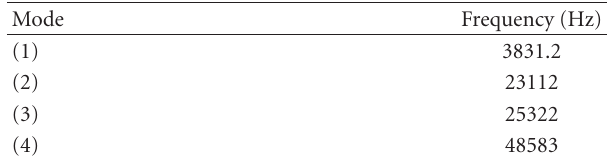
Table 2: The first four natural frequencies of one rotor